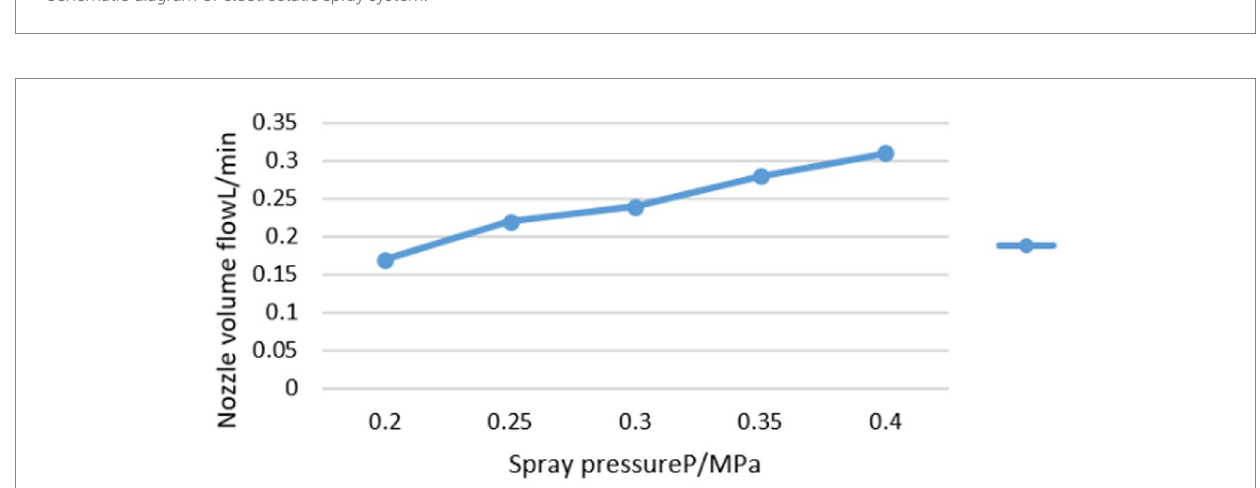
FIGURE 5 Schematic diagram of electrostatic spray system.